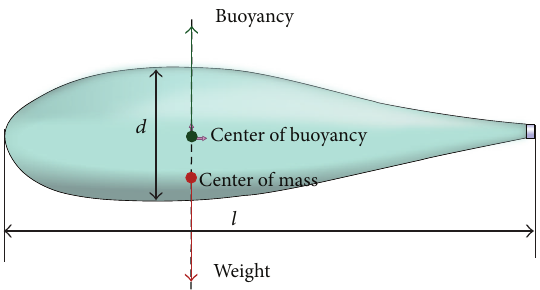
Figure 3: The overall body shape of UC-Ika